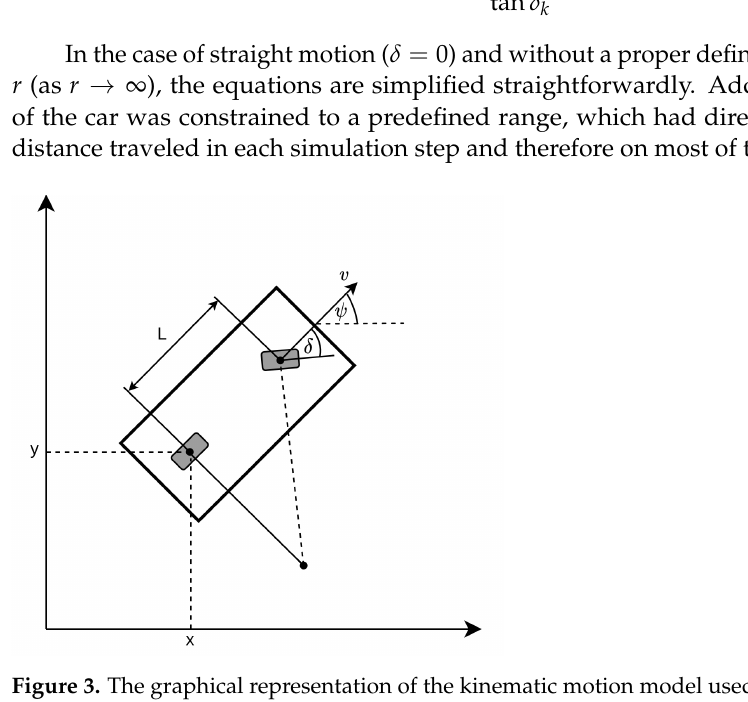
Figure 3. The graphical representation of the kinematic motion model used for the